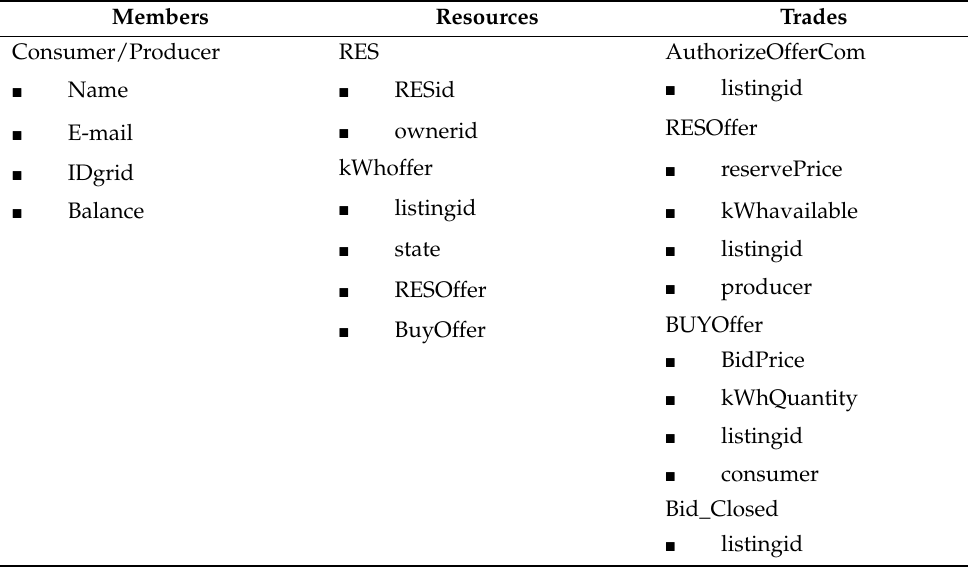
Table 9. Members, resources and trades of the trading platform.